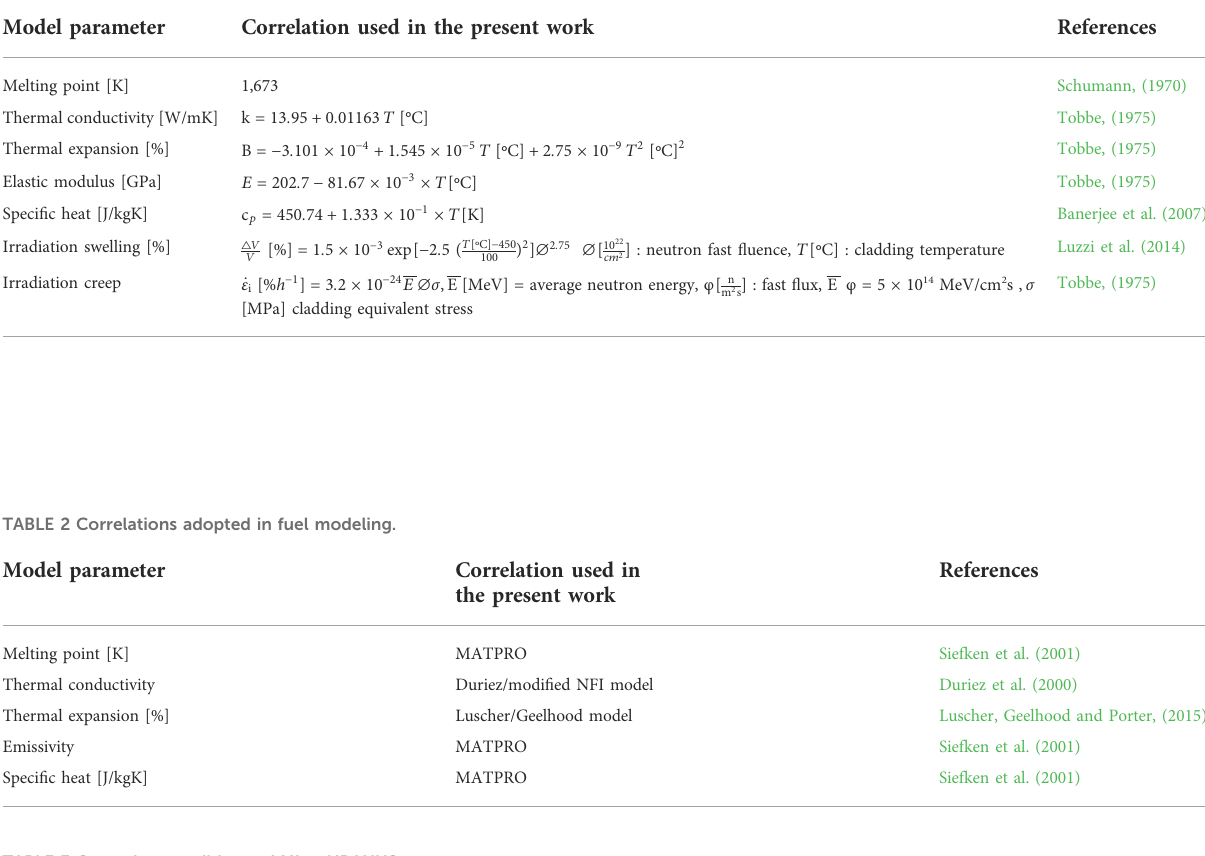
TABLE 3 Operation conditions of